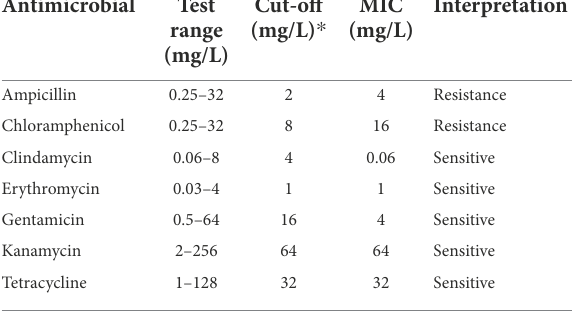
TABLE 2 Antimicrobial resistance (AMR) phenotype of L. pentosus 9D3. Antimicrobial